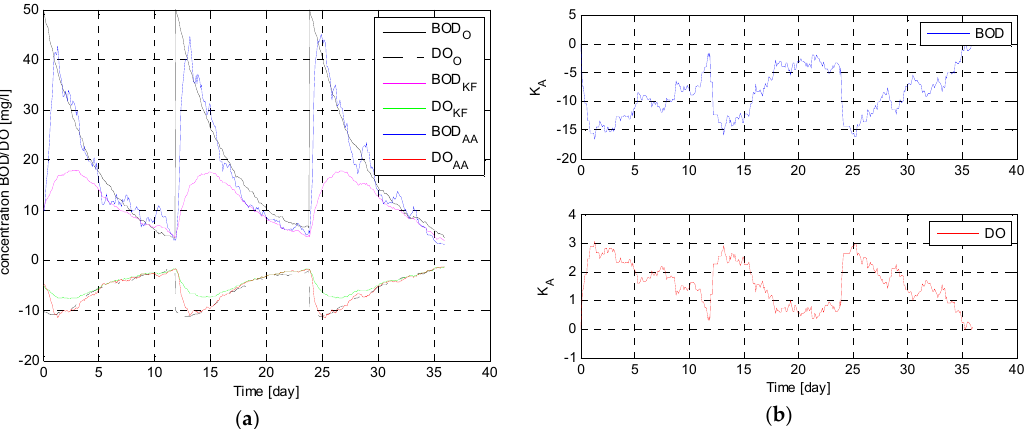
Figure 10. Distribution of BOD and DO signals ( a ) and adaptive algorithm gain coefficients ( b ) for matrices W = [3, − 2; − 2, 1] and V = [0.9].